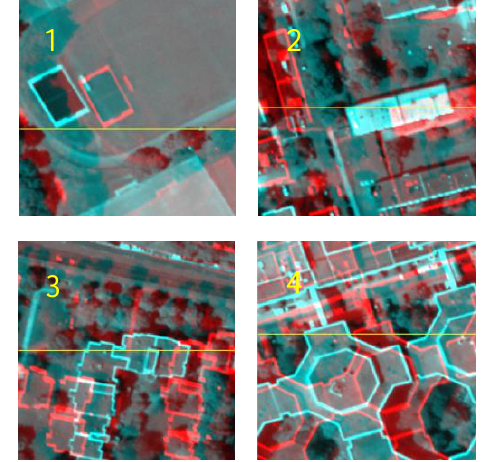
Figure 9. Sub-images at the corners of WorldView-2 anaglyph In order to do further quantitative experiments, forty corresponding points are created from the QuickBird stereo image and 260 corresponding points are generated from the WorldView-2 images. The selected corresponding points are distributed over the entire image evenly. We generate the epipolar curves for these points, and then measure the distances from the corresponding points to the related epipolar curves. Figure 6. Anaglyph image of QuickBird data The distances are applied to show the y-parallaxes. The results of two test datasets are shown in Figure 10.